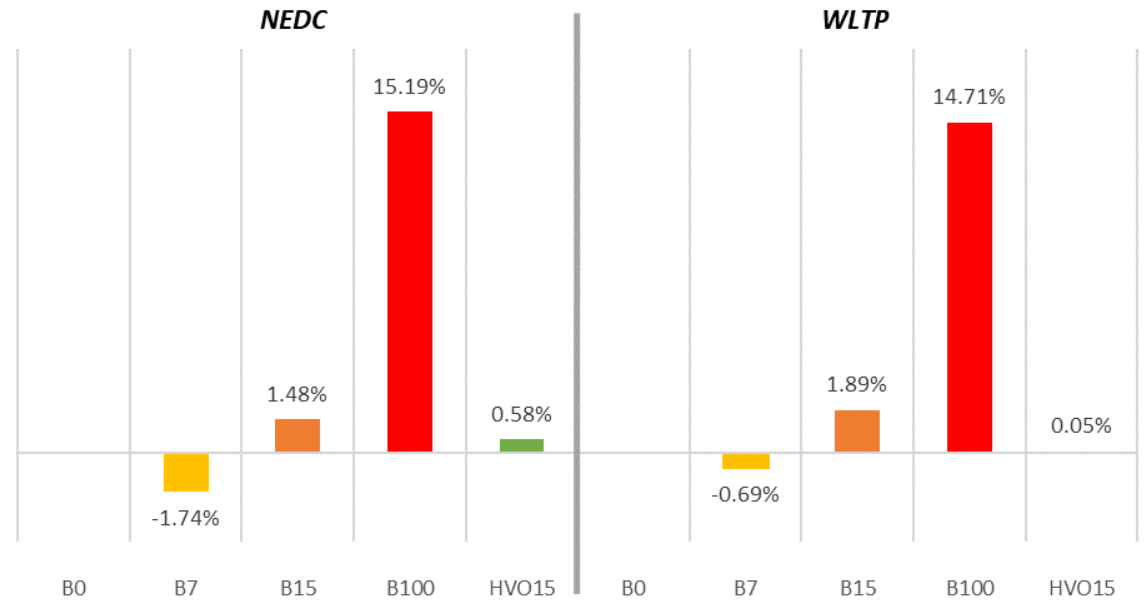
Figure 2. Percentual differences of the mass of fuel consumed when compared with the B0 fuel, depending on the fuel used.